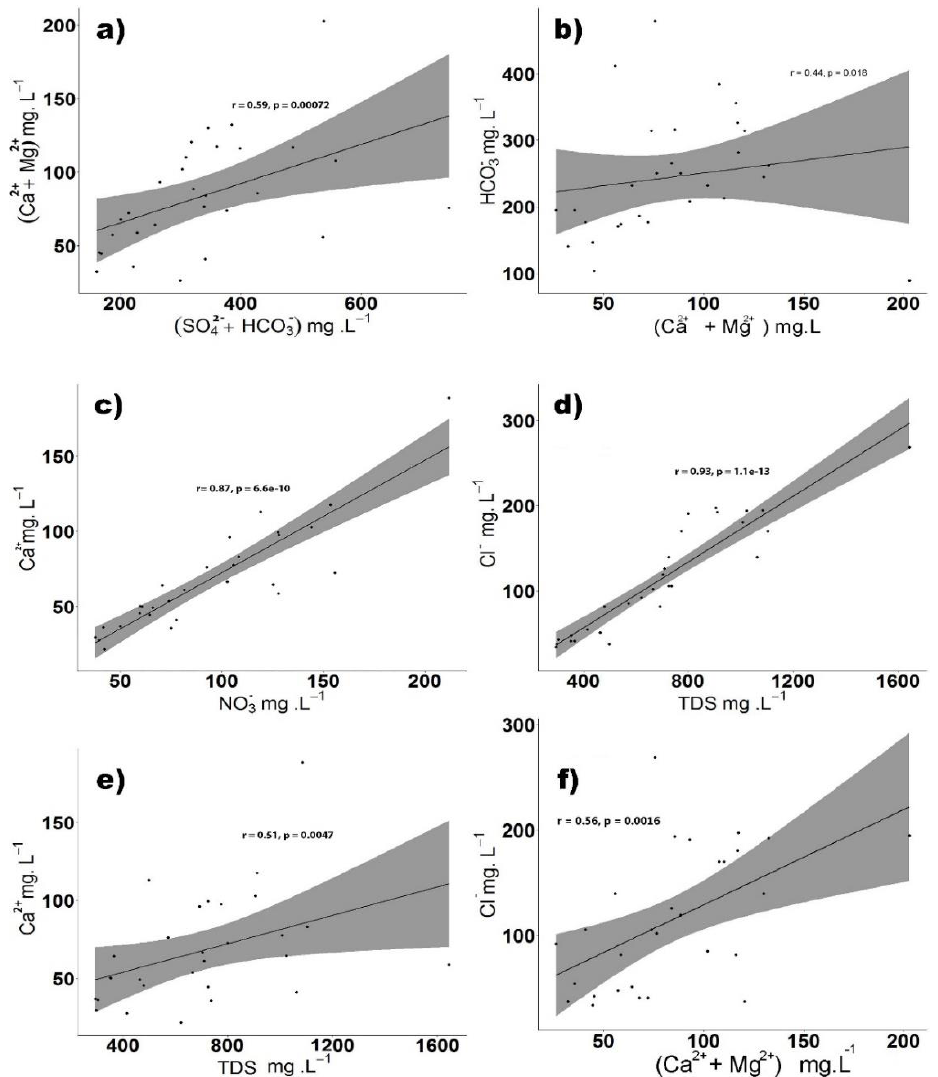
Figure 4. Bivariate plots of ( a ) Ca 2+ + Mg 2+ vs. SO 42 − + HCO 3 − , ( b ) HCO 3 − vs. Ca 2+ + Mg 2+ , ( c ) Ca 2+ vs. NO 3 − , ( d ) Cl − vs. total dissolved solids (TDS), ( e ) Ca 2+ vs. TDS, and ( f ) Cl − vs. Ca 2+ + Mg 2+ .